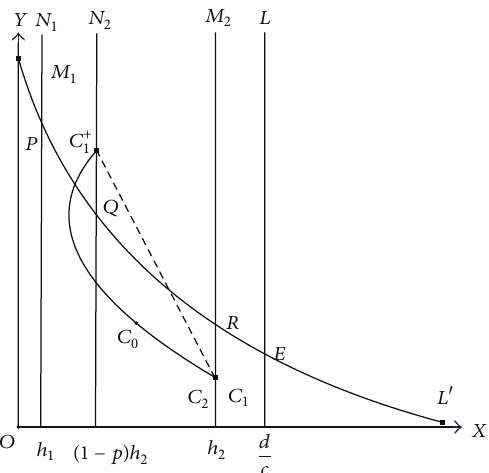
Figure 13: The orbit starting from the point 𝐶 0 (Case 2 in Section 4.1.3).